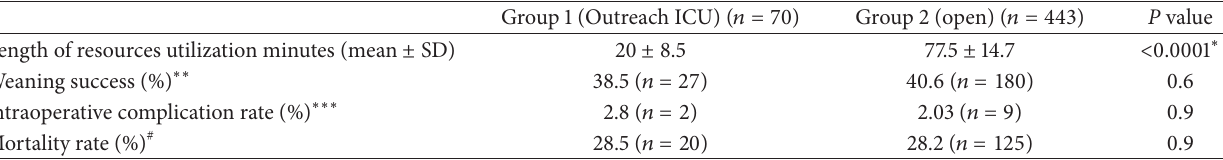
Table 3: Outcome endpoints (mean ± SD, %).